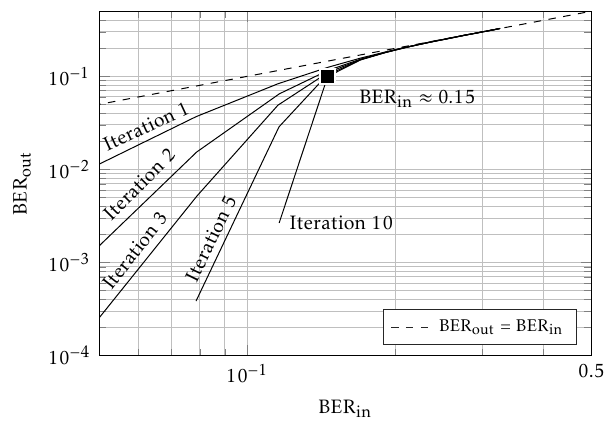
Figure 6. OutputBER as a functionof the input BER for a rate= 1 / 2 LDPC system. In this configuation, the convergence thresholdis at an inputBER of 0.15.